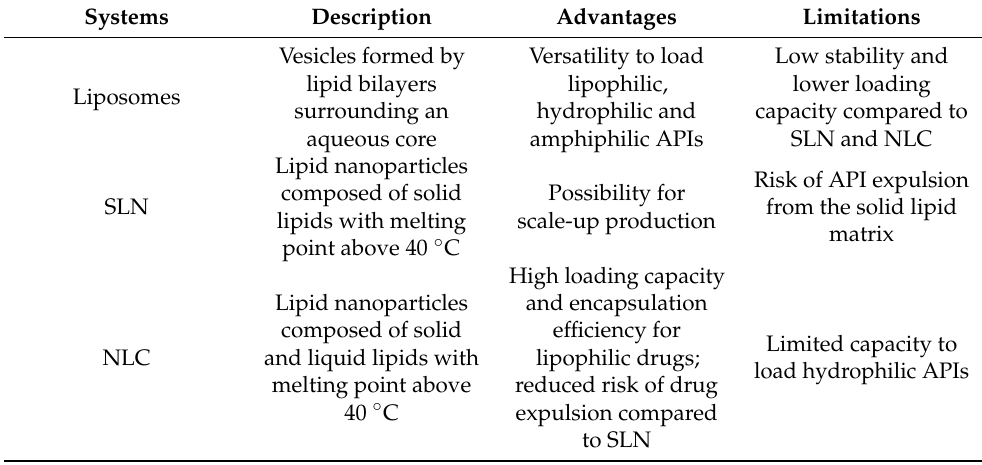
Table 1. Types of lipid nanocarriers proposed for the treatment of hyperproliferative skin diseases.